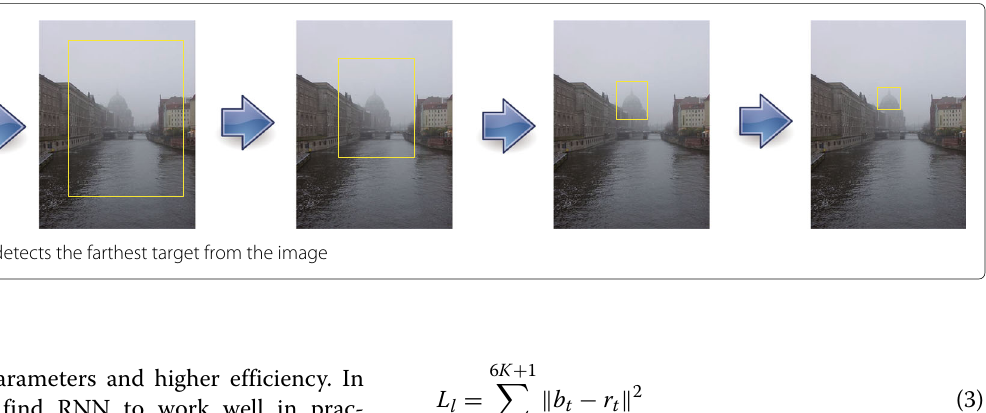
RNN for its fewer parameters and higher efficiency.